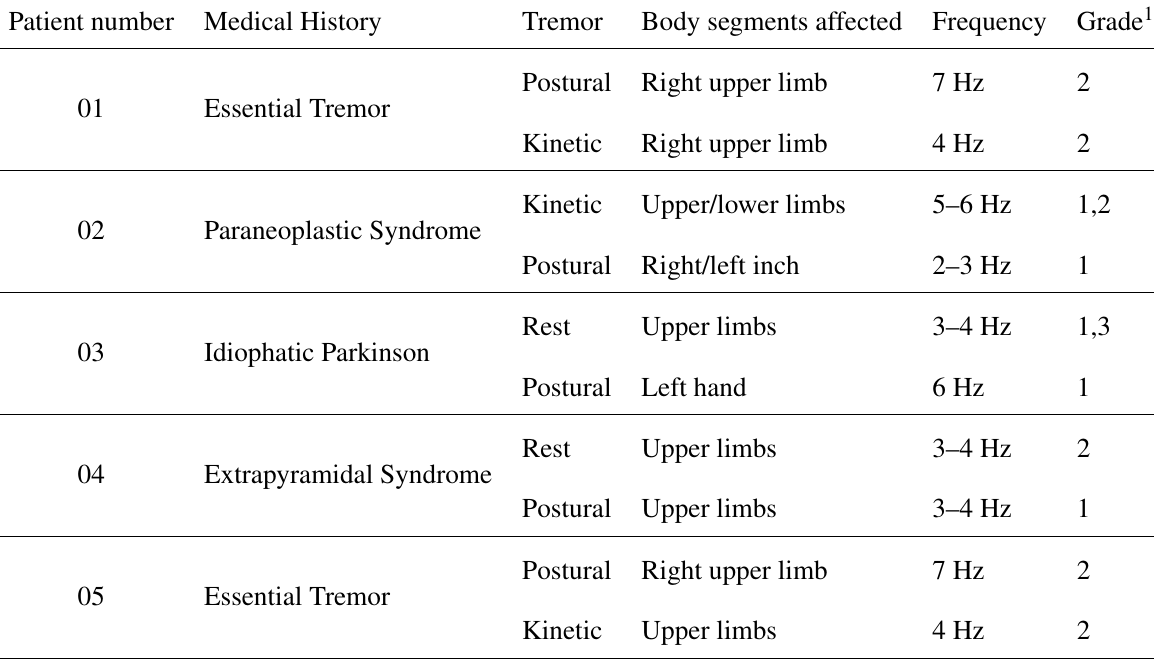
Table 1 . Clinical features of enroled